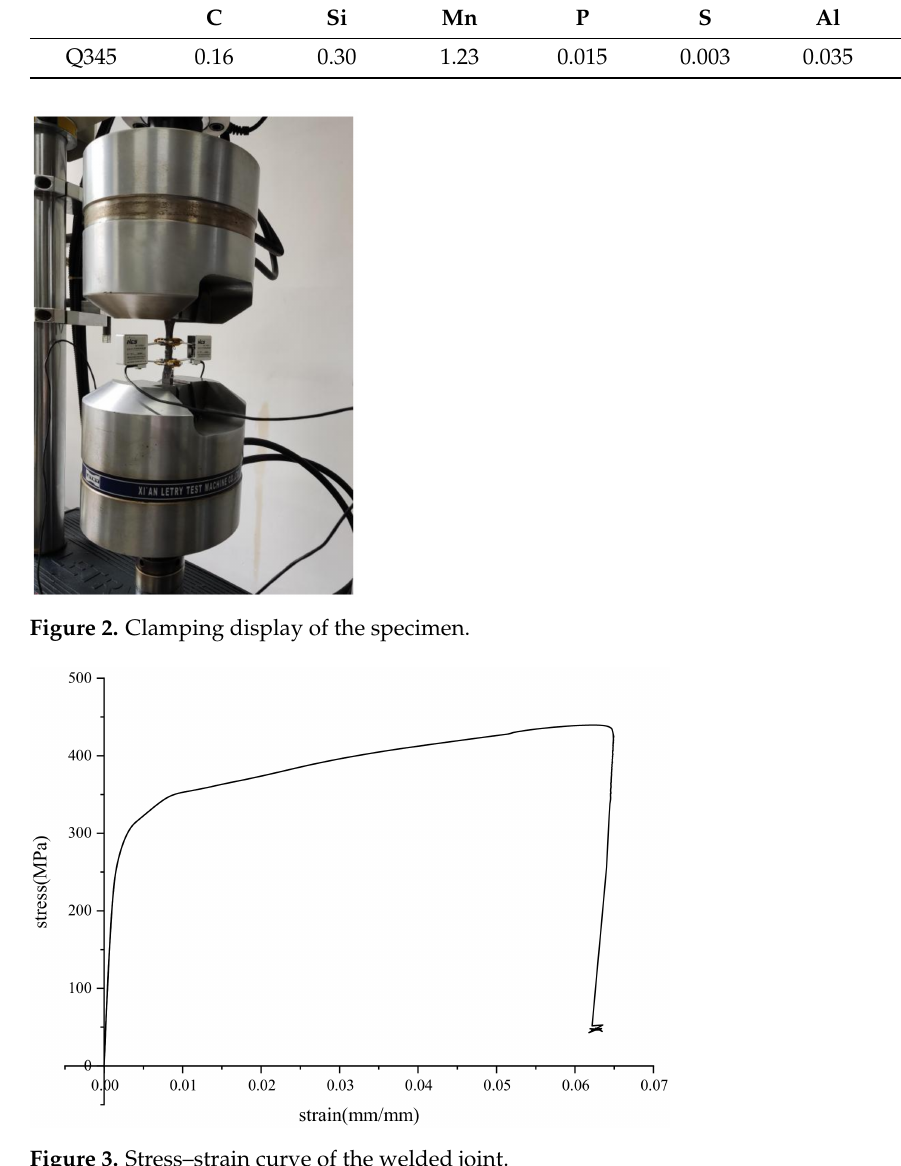
Figure 3. Stress–strain curve of the welded joint. Table 2. Mechanical parameters of the welded